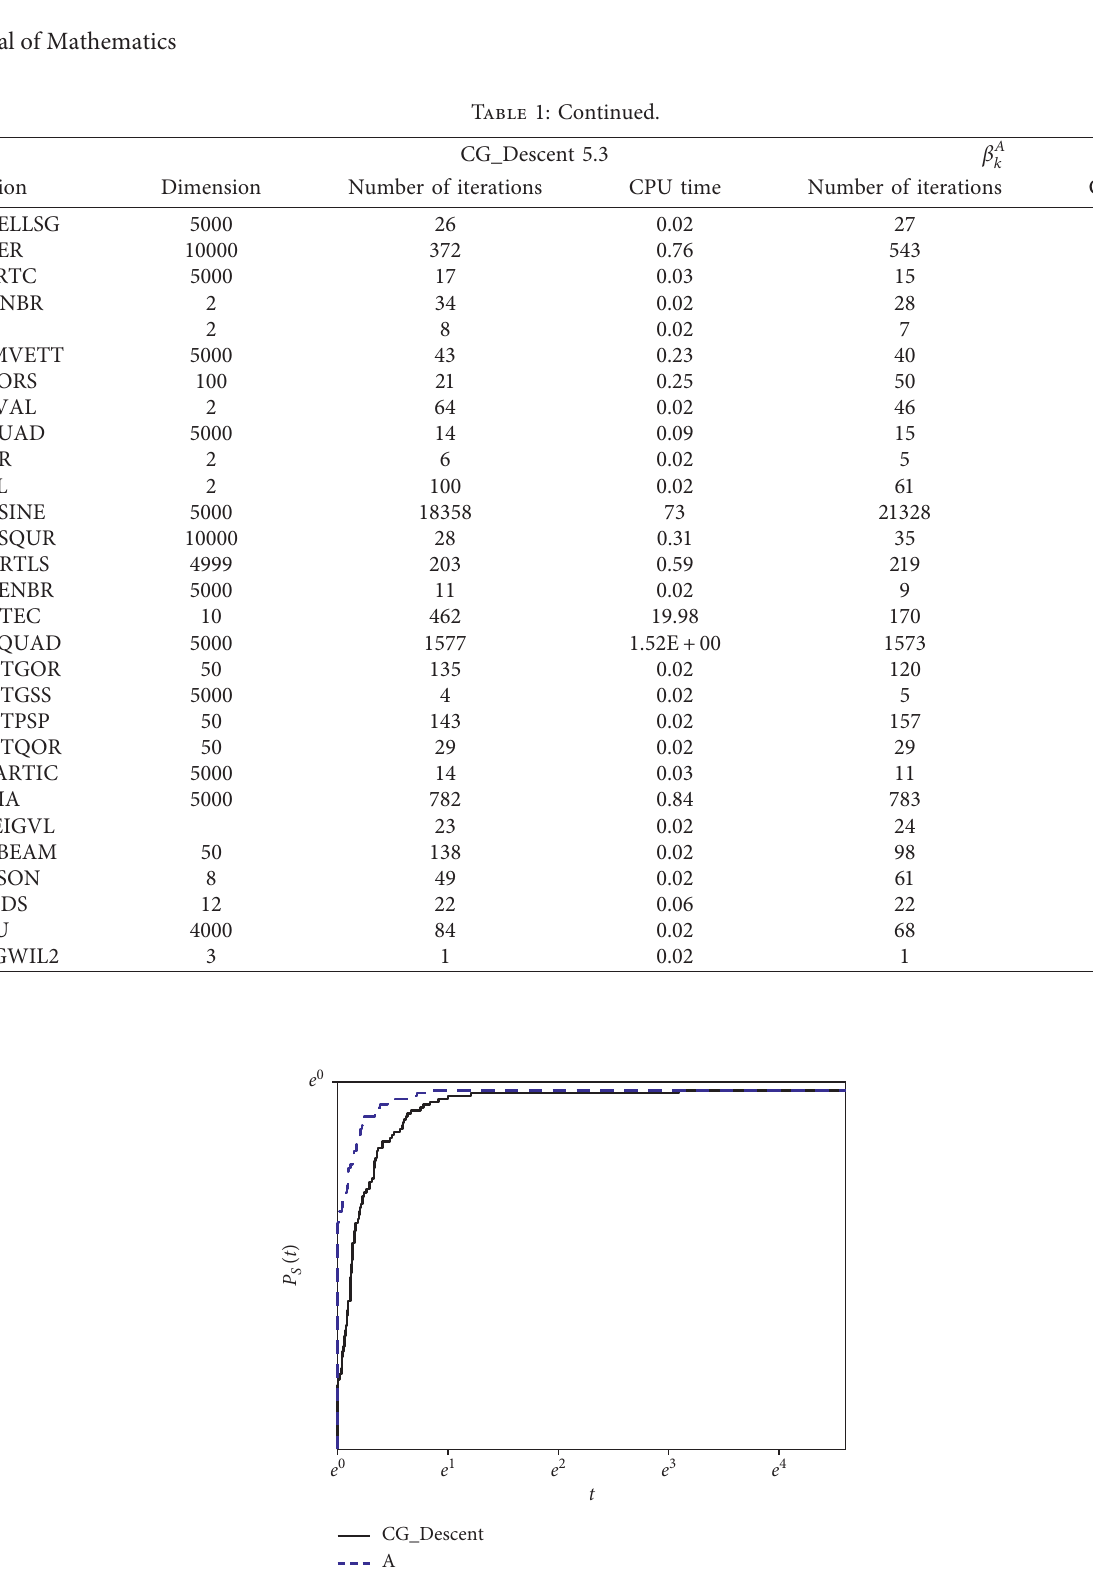
Figure 1: Performance measure based on the number of